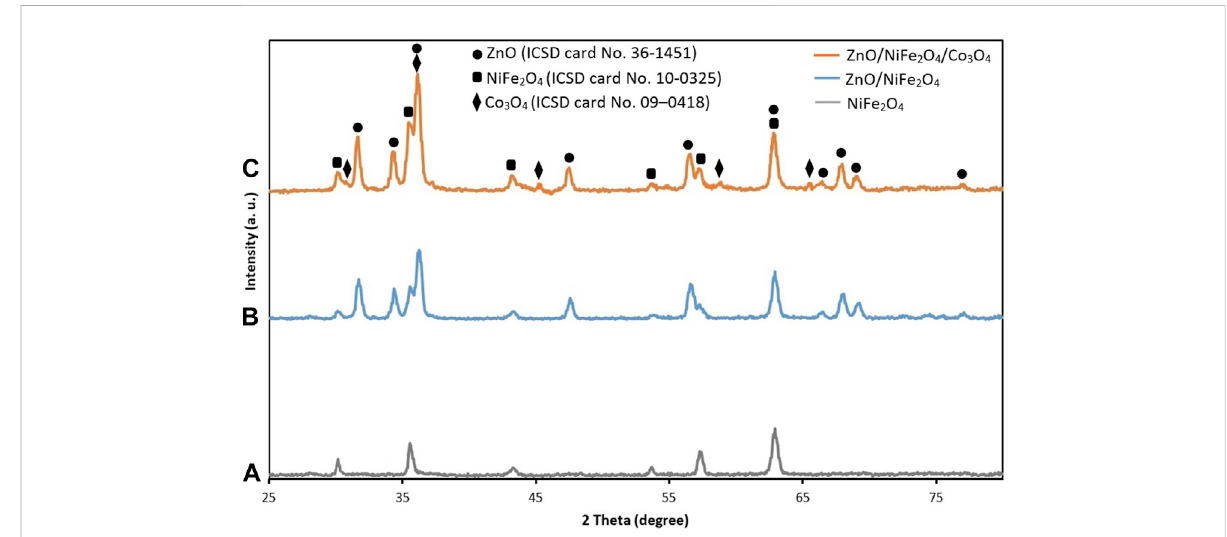
FIGURE 3 XRD patterns of (A) NiFe 2 O 4 , (B) ZnO/NiFe 2 O 4 and (C) ZnO/NiFe 2 O 4 /Co 3 O 4